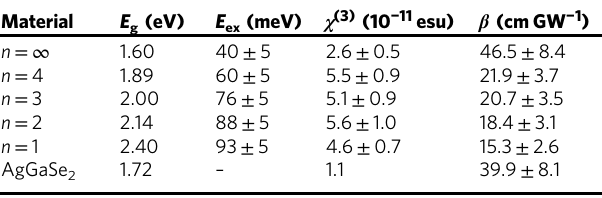
Fig. 3 Two-photon absorption and photoluminescence characteristics and two-photon absorption coef fi cient vs. bandgap. a I input vs. I output for n = 4 ( dots ) at λ = 1064nm, superimposed with a two-photon absorption (2PA) fi t ( red curve ) with β = 21.9cmGW – 1 . The black line corresponds to β = 0. b 2PA-induced photoluminescence (PL) spectra ( n = 4) at λ = 1064nm under various excitation levels. c Intensity dependence of the resulting PL from n = 4 ( dots ) fi tted with the square law ( red curve ), indicating the case for 2PA. d Log – log plot of the scaled 2PA coef fi cient, β n 2 determined K = 5000. The data point for n = 1 is missing because in this case 2PA is purely excitonic and F 2 ( x ) is not well de fi ned. The red line is E (cid:2) 3 Table 1 The Bandgap energy ( E g ), exciton-binding energy ( E ex ), third-order susceptibility ( χ (3) = n 0 n 2 /9.43), and two- photon absorption coef fi cients ( β ) of 2D Ruddlesden-Popper perovskites ( n = 1 – 4) and 3D materials ( n = ∞